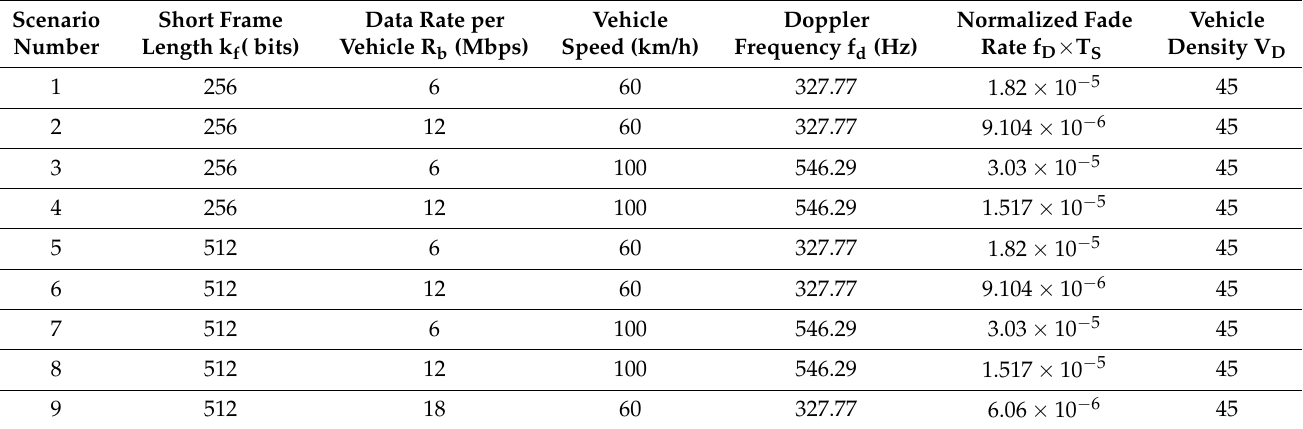
Table 2. Simulation scenarios with different parameters and constant vehicle